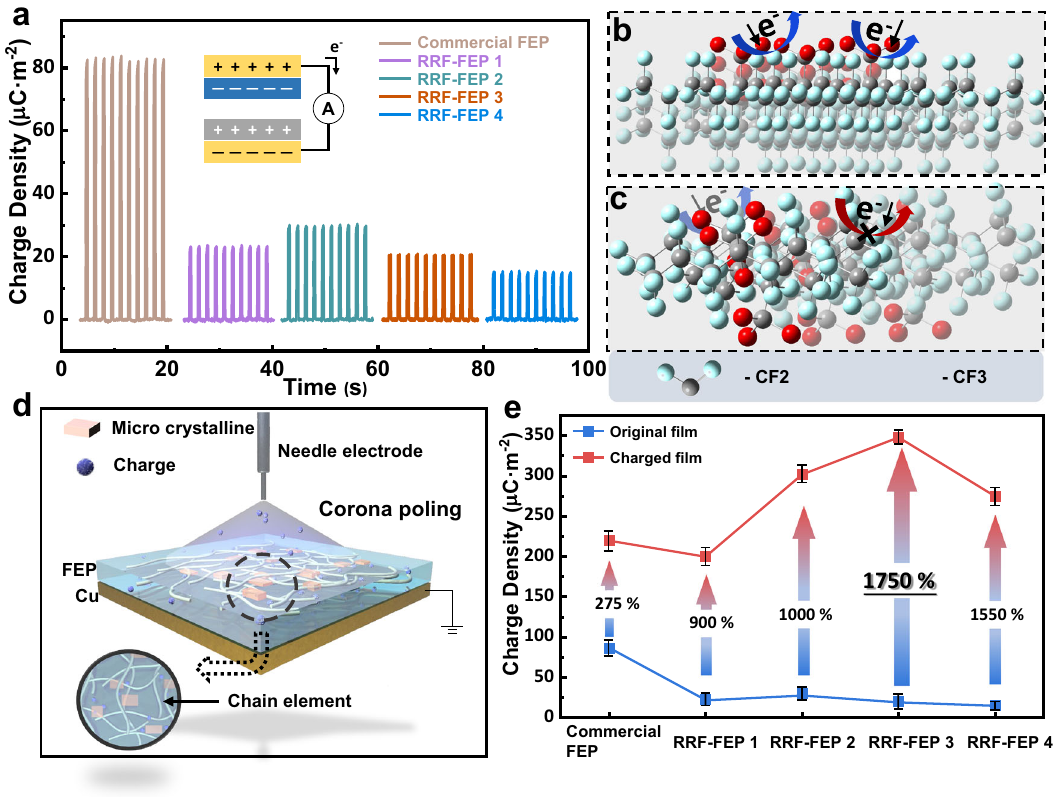
Fig. 3 Effect of corona polarization on the performance of FEP. a Maximum saturated charge density between FEP (without corona poling) and PA measured by contact-separation TENG. b The schematic models illustrating the commercial FEP. c The schematic models illustrating the RRF-FEP. d Schematic diagram of corona poling process. e Schematic diagram of charge injection process. e Comparison diagram of saturated charge density of FEP fi lms before and after polarization. The error bar is obtained by repeating the test for ten times. Source data are provided as a Source Data fi